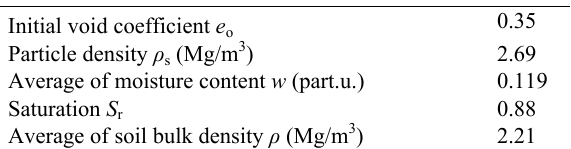
Table 2. Physical properties of the sample investigated with the oedometer and direct shear tests